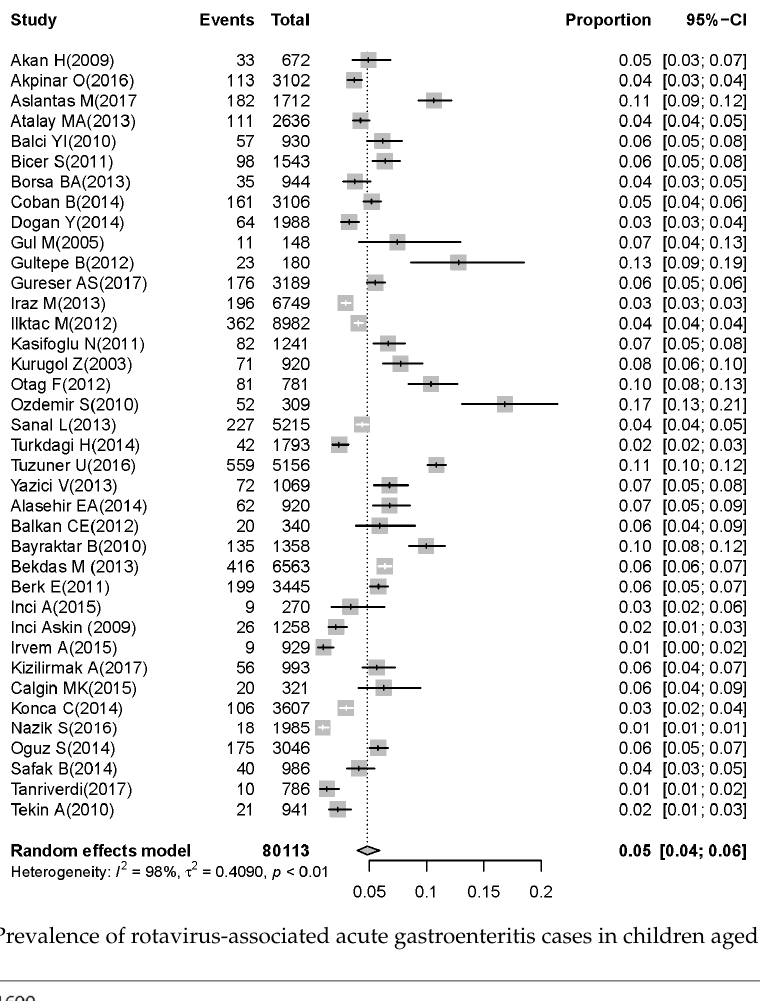
Figure 3. Prevalence of rotavirus-associated acute gastroenteritis cases in children aged 0 – 2 years.